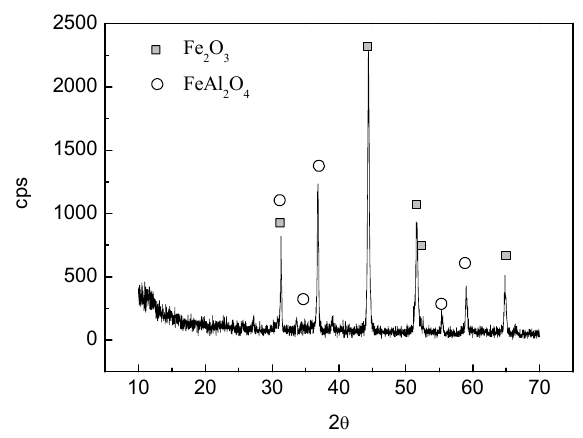
Figure 6. X-ray diffraction pattern of the anode surface after electrolysis.